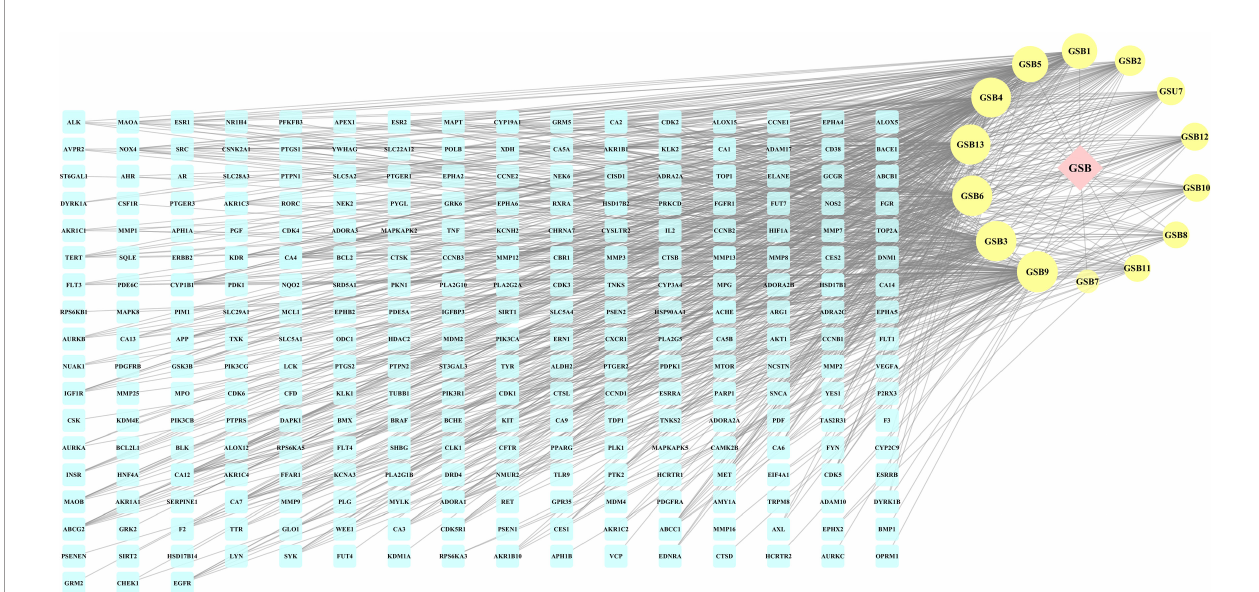
FIGURE 3 | The herb-compounds-targets network of 287 nodes. The pink node represents TFDR, the light-yellow nodes represent its compounds and the light blue nodes represent the gene symbols. The size of node is proportional to the degree value and the edges represent interactions between the